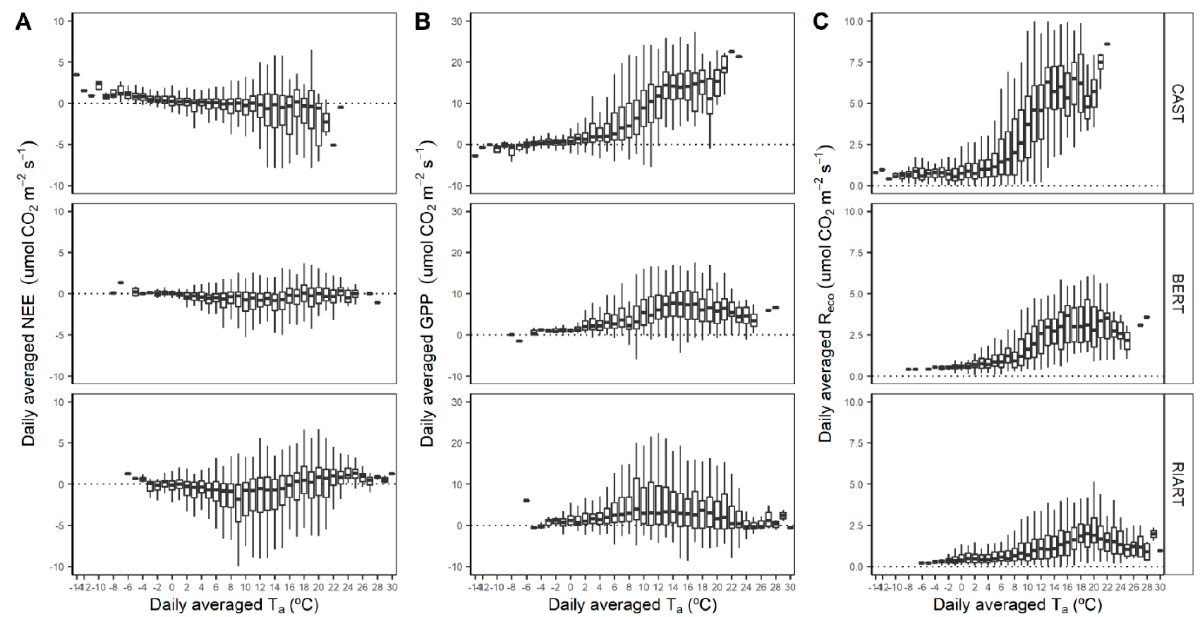
Figure 6. Daily averaged CO 2 fluxes as function of daily averaged ambient temperature (T a ): ( A ) net ecosystem exchange (NEE); ( B ) gross primary production (GPP); and ( C ) ecosystem respiration (R eco ). The boxplots display the first and the third quartile (boxes), the median (horizontal line), and the minimum and maximum values (whiskers).